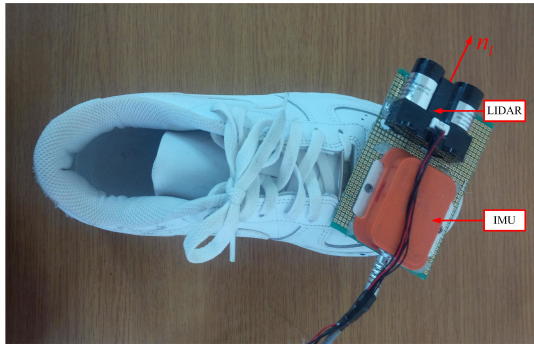
Figure 6. IMU and LIDAR system for the